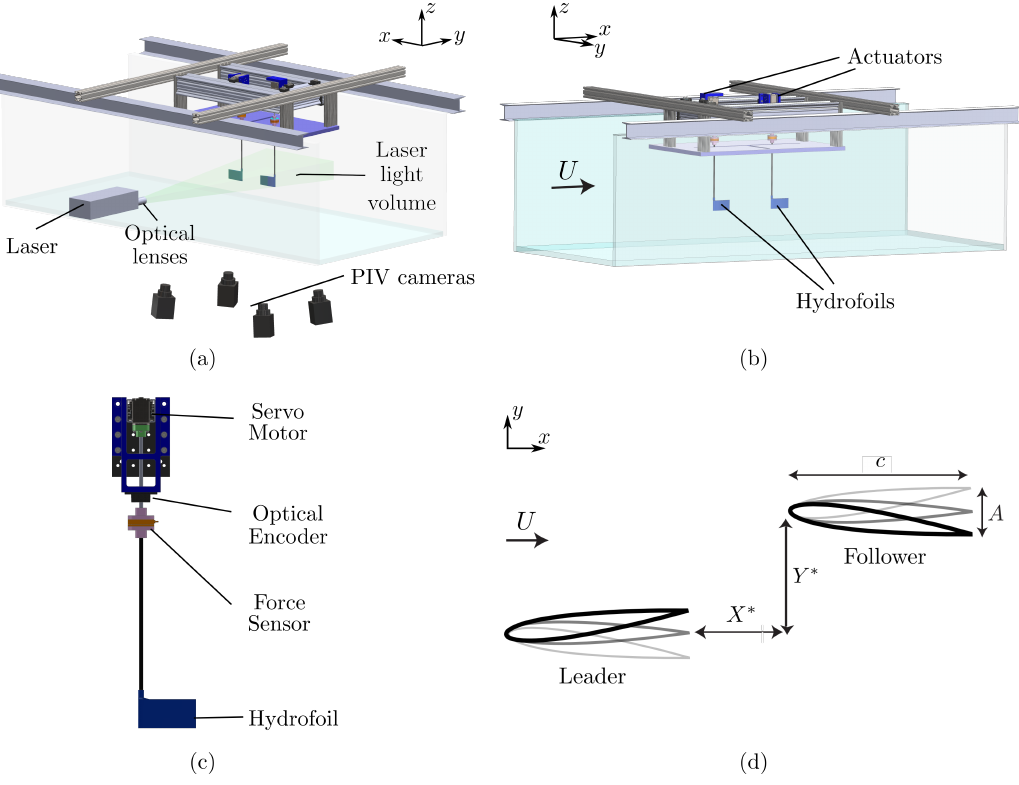
Figure 3. ( a ) A schematic of the tomo PIV experimental facility. ( b ) A schematic of the